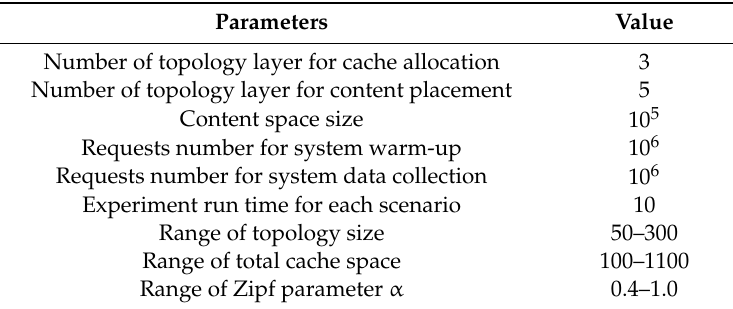
Table 2. Experiment